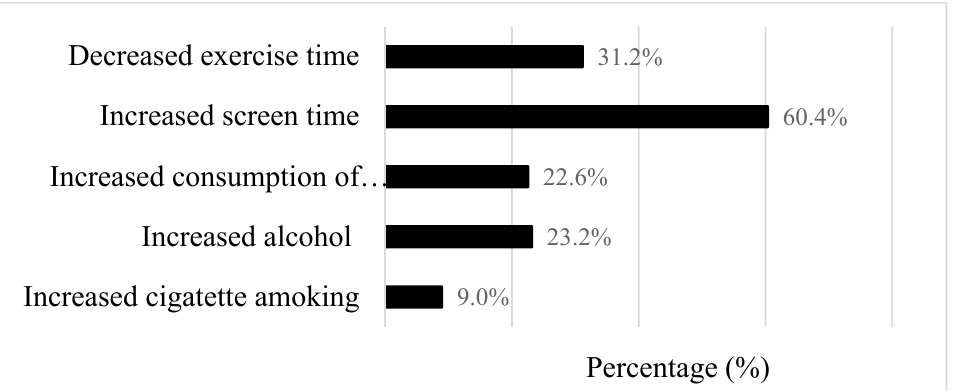
Figure 2. Bar chart for percentage (%) of undesired changes in 5 lifestyle behaviors during the COVID-19 pandemic. Changes in lifestyle behaviors were calculated (during pandemic–before pandemic) and categorized as “desired change” or “undesired change” for each behavior. The “undesired change” category refers to decreased exercise, increased screen time, increased numbers of fast-food meals, increased cigarettes smoking, or increased alcohol drinking during the pandemic as compared with before the pandemic, respectively, for each behavior.